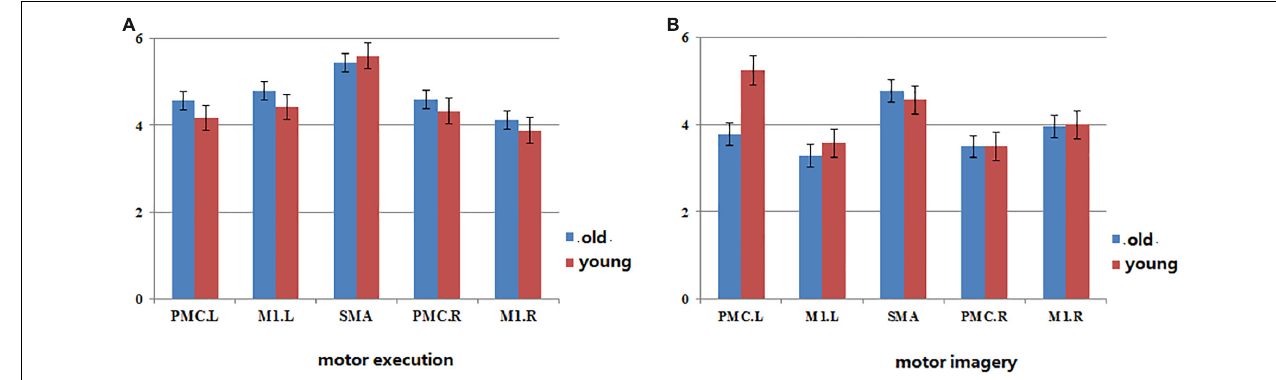
FIGURE 4 | The map of statistical analysis of In+ut degree in each ROI in the groups. Blue bar indicates the average of In+Out degree across all subjects in old group, red bar indicates the average of In+Out degree across all subjects in young group. (A) The In+Out degree in motor network during motor execution in young and old group. (B) The In+Out degree in motor network during motor imagery in young and old